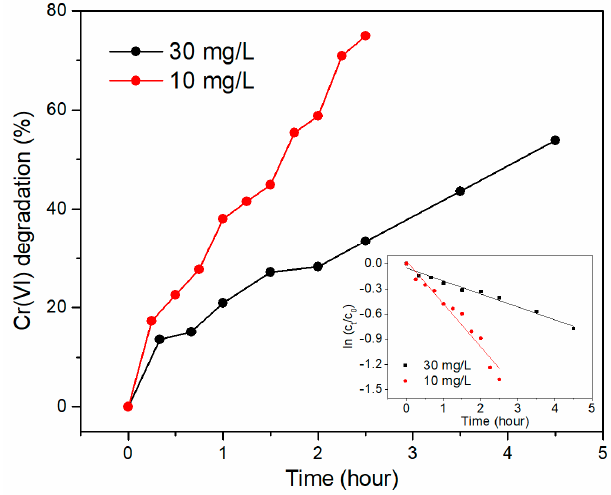
Figure 4. Removal efficiencies of Cr (VI) with different initial concentration by MFCs equipped with pyrrhotite-coated cathode (Inserted image: Linear relationship between ln(C/C 0 ) and time).